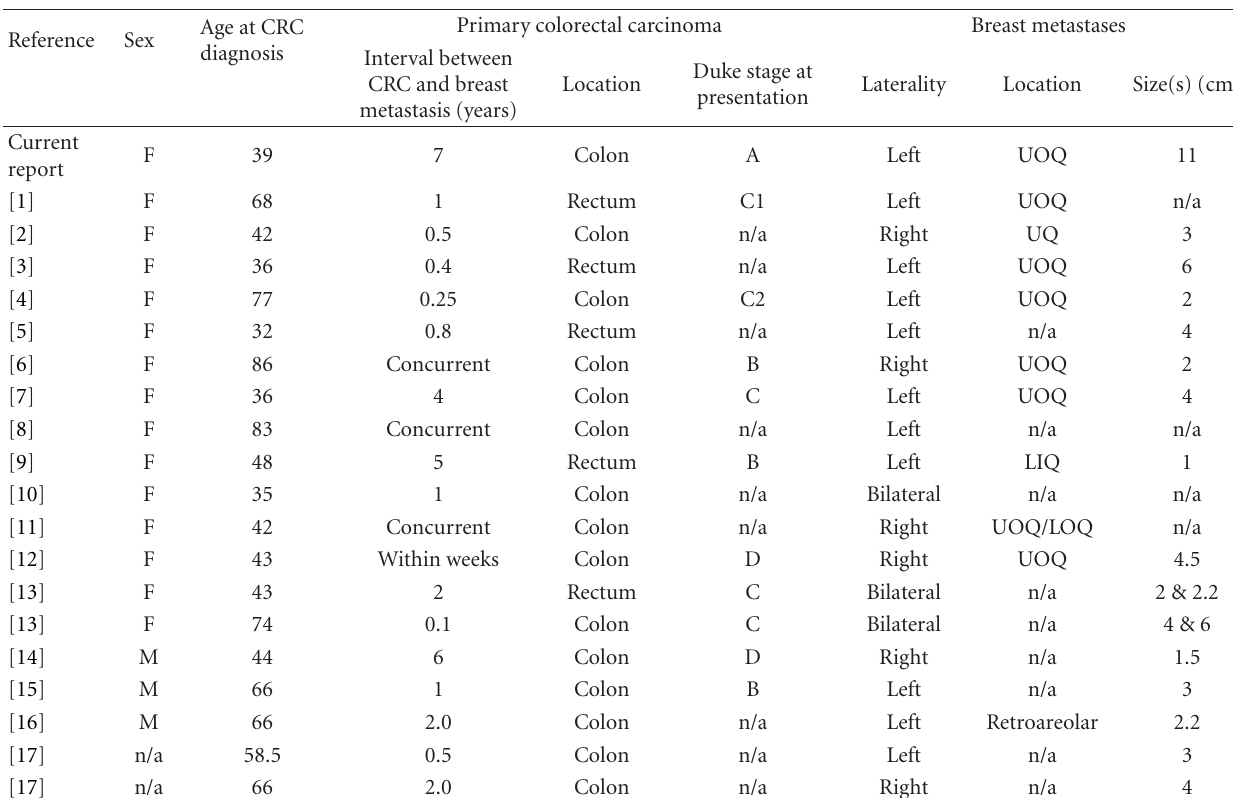
Table 1: Colorectal carcinoma metastatic to the breast: summary of cases.